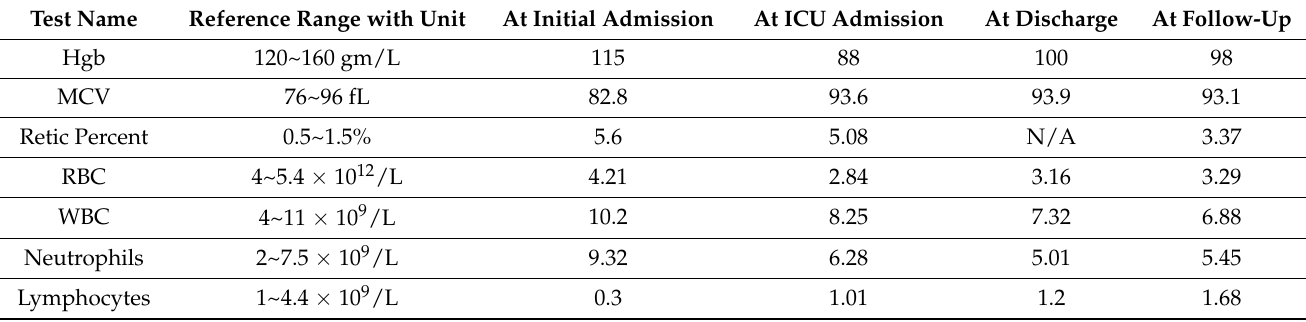
Table 1. Important Laboratory Values at Hospital Admission, ICU Admission/One-Day Preopera- tively, Discharge, and